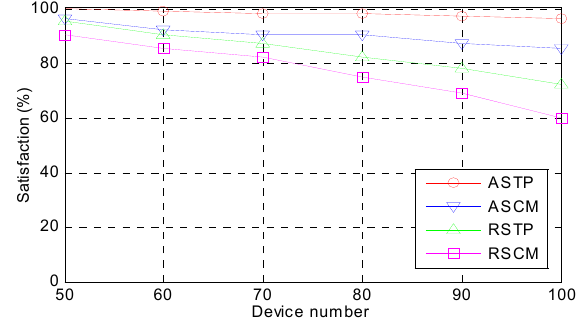
Figure 7. Comparison of satisfaction.